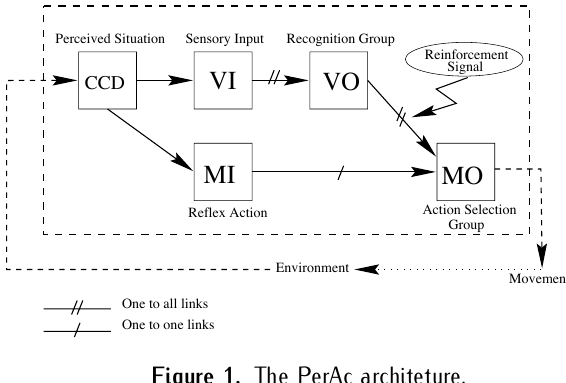
Figure 1. The PerAc